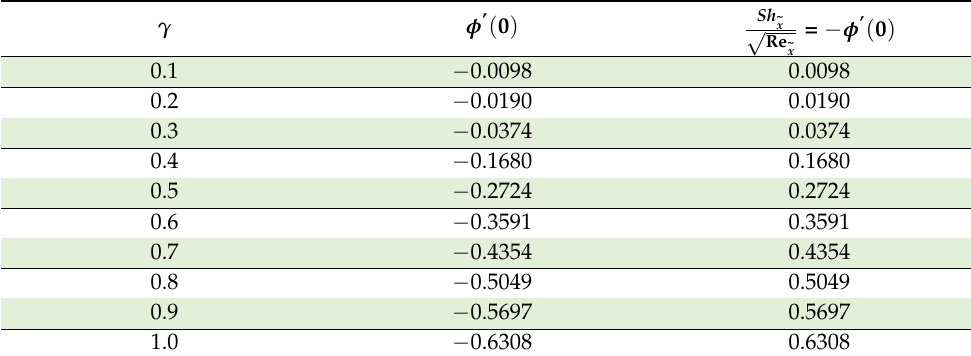
Table 11. Effect of γ on Sherwood